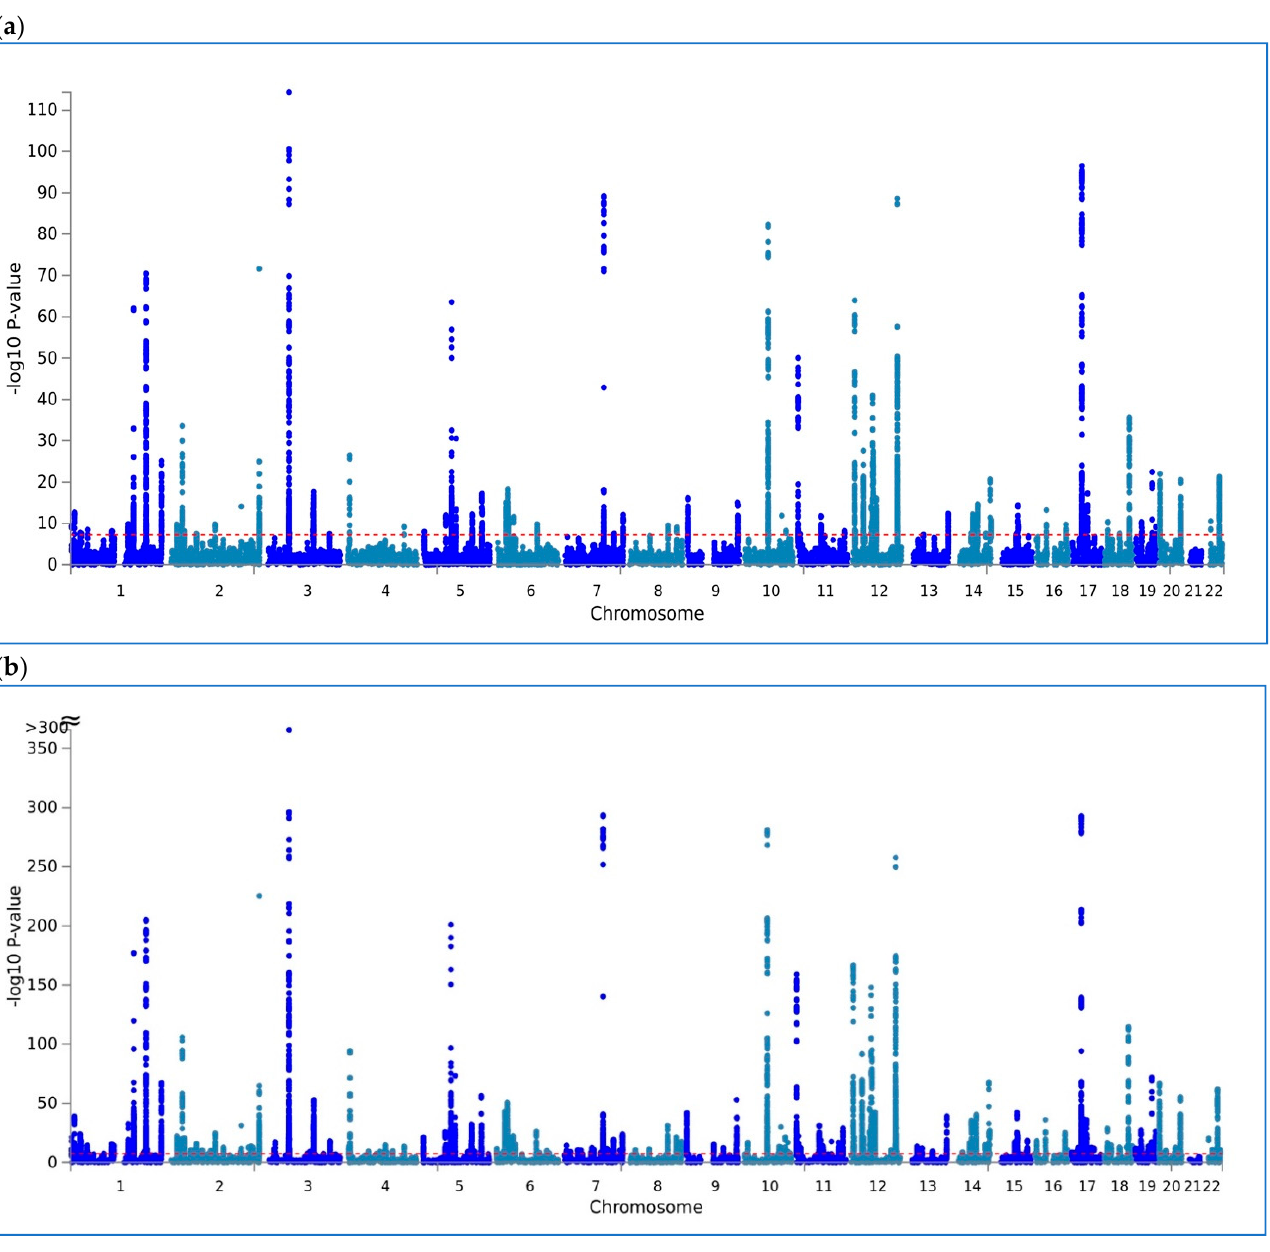
Figure 1. Manhattan Plot of multitrait single-variant associations with ( a ) PD-AAO and ( b )